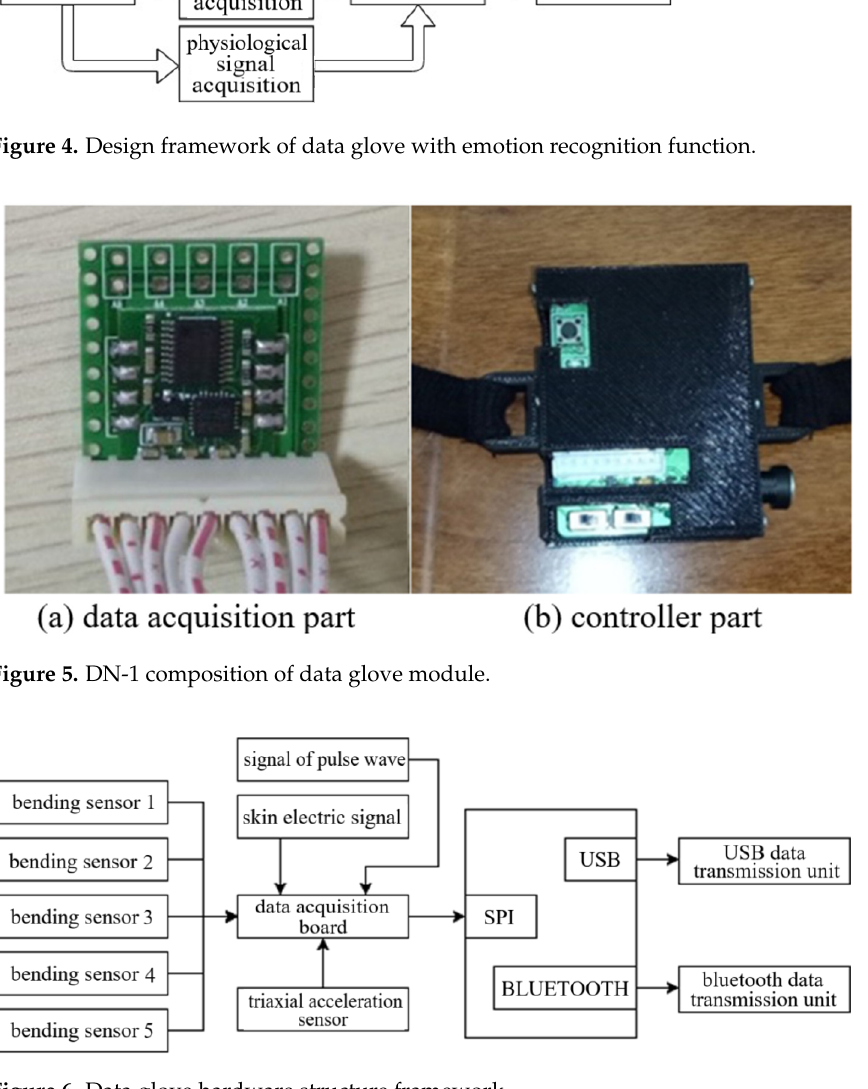
Figure 7. Prototype design of data glove based on emotion recognition of physiological signal. The skin electrical signal is acquired using a Grove-GSR skin electrical kit, as shown in Figure 8 (left). Two finger sleeves containing electrodes were put on the middle part of the middle finger and the thumb of the left hand, and the frequency of signal sampling